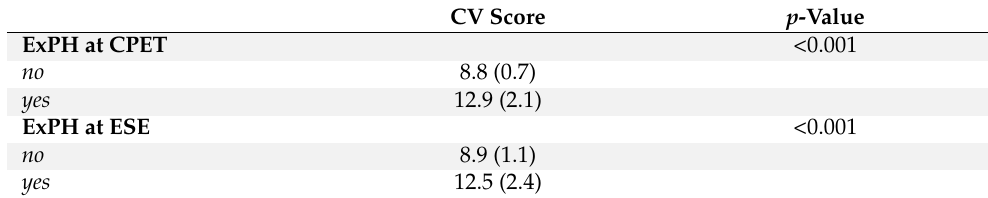
Table 1. Comparison between score and ExPH.